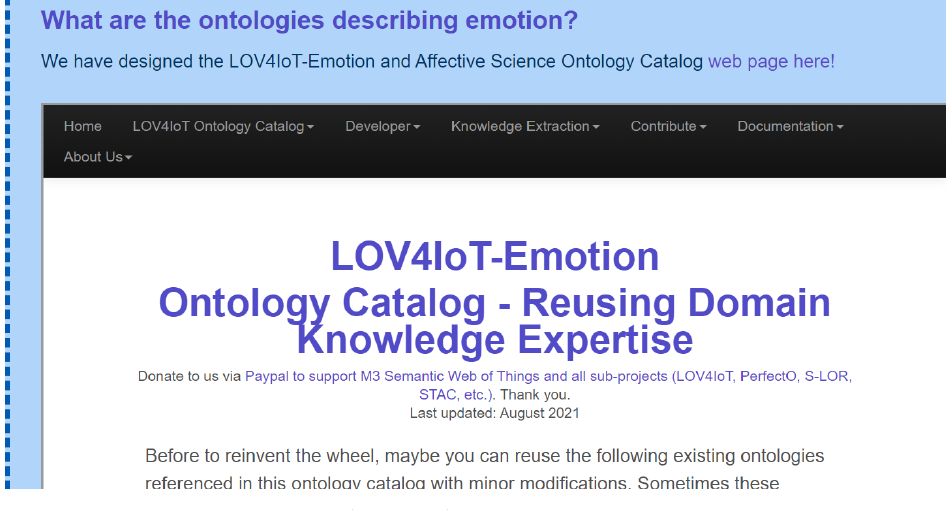
Figure A2. LOV4IoT-Emotion Ontology